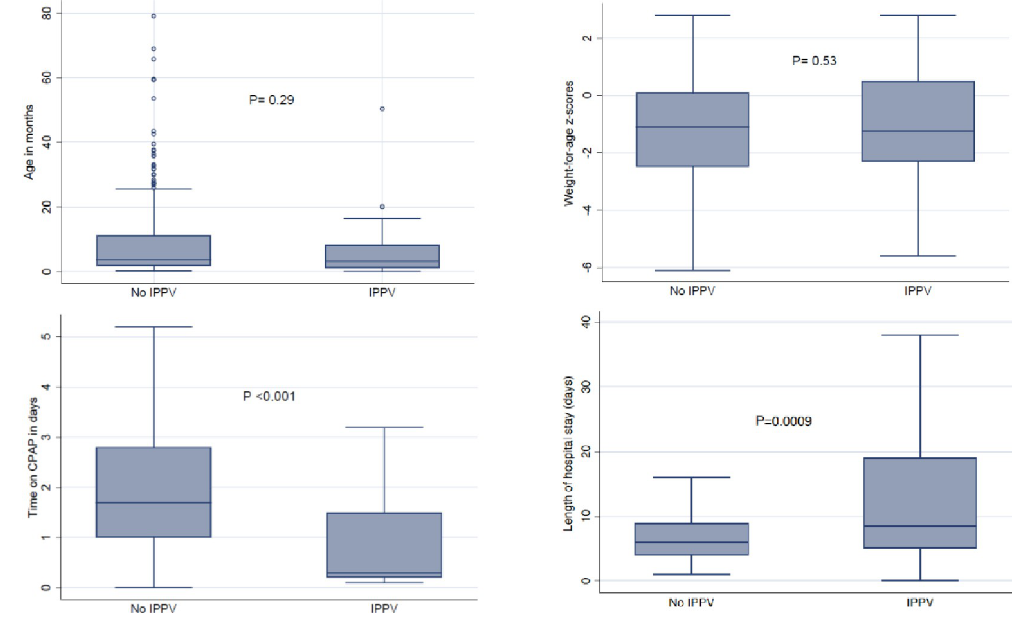
Fig 3. Comparison of children requiring intubation vs. those who did not. IPPV- invasive ventilation; bCPAP- bubble continuous positive airways pressure.